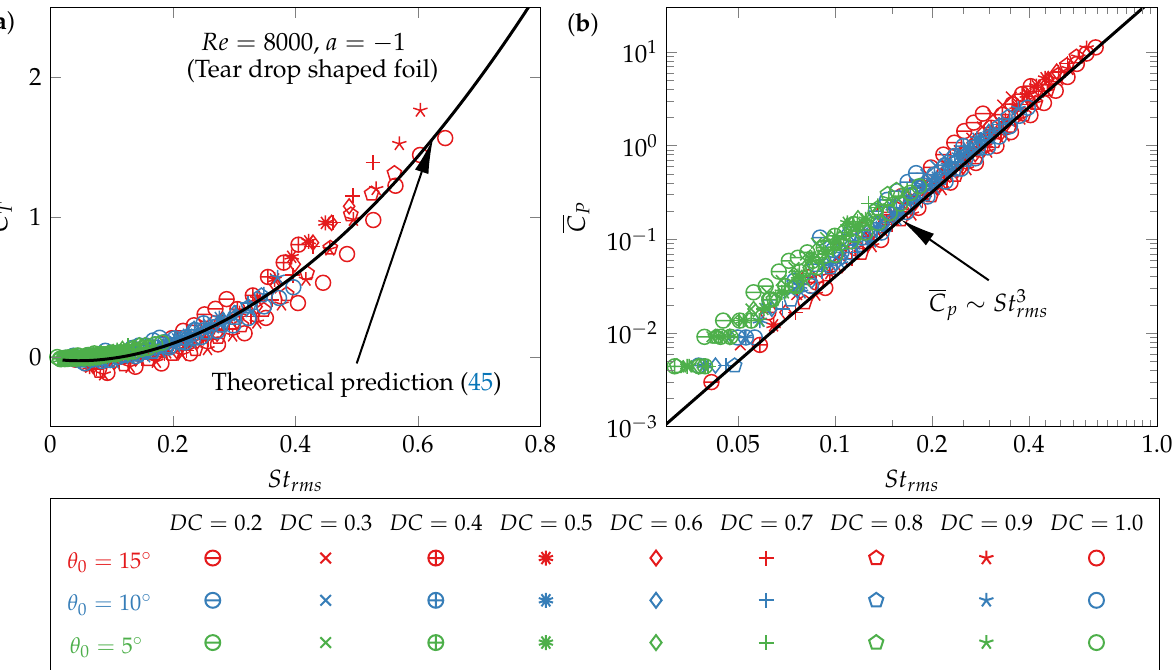
Figure 4. Mean thrust and power coefficients C T and C P as a function of the root mean square Strouhal number St rms for foils undergoing prescribed intermittent rotational pitch with duty cycles ( DC ) ranging from 0.2 to 1.0 and angular amplitudes θ 0 = 5 ◦ , 10 ◦ and 15 ◦ . Discrete points are taken from the experimental investigation of Floryan et al. [40] for a tear drop shaped foil pitched about its leading edge at Re = 8000. Distinct symbols and colors are used to distinguish between cases associated with distinct DC and θ 0 , respectively. The solid line in the left panel ( a ) represents the theoretical prediction (45) while the one in the right panel ( b ) is a cubic power law